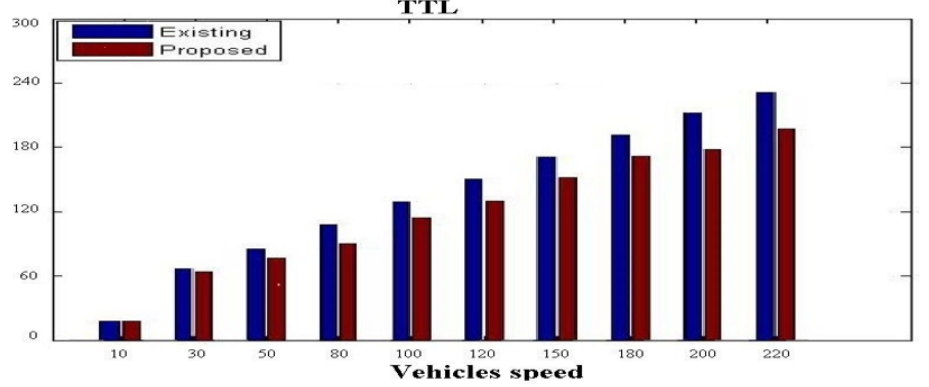
Figure 8. TTL (seconds).